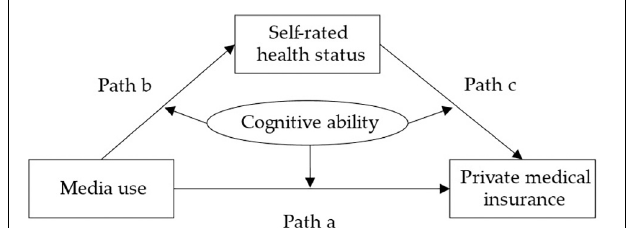
FIGURE 1 | Conceptual